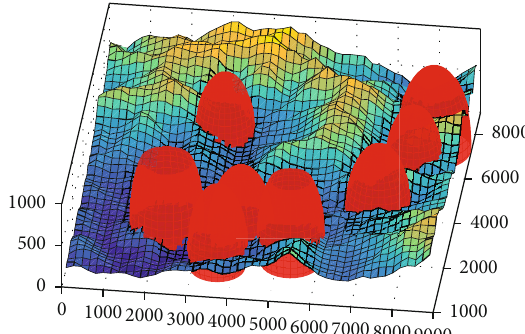
Figure 1: The environment with the terrain and the danger